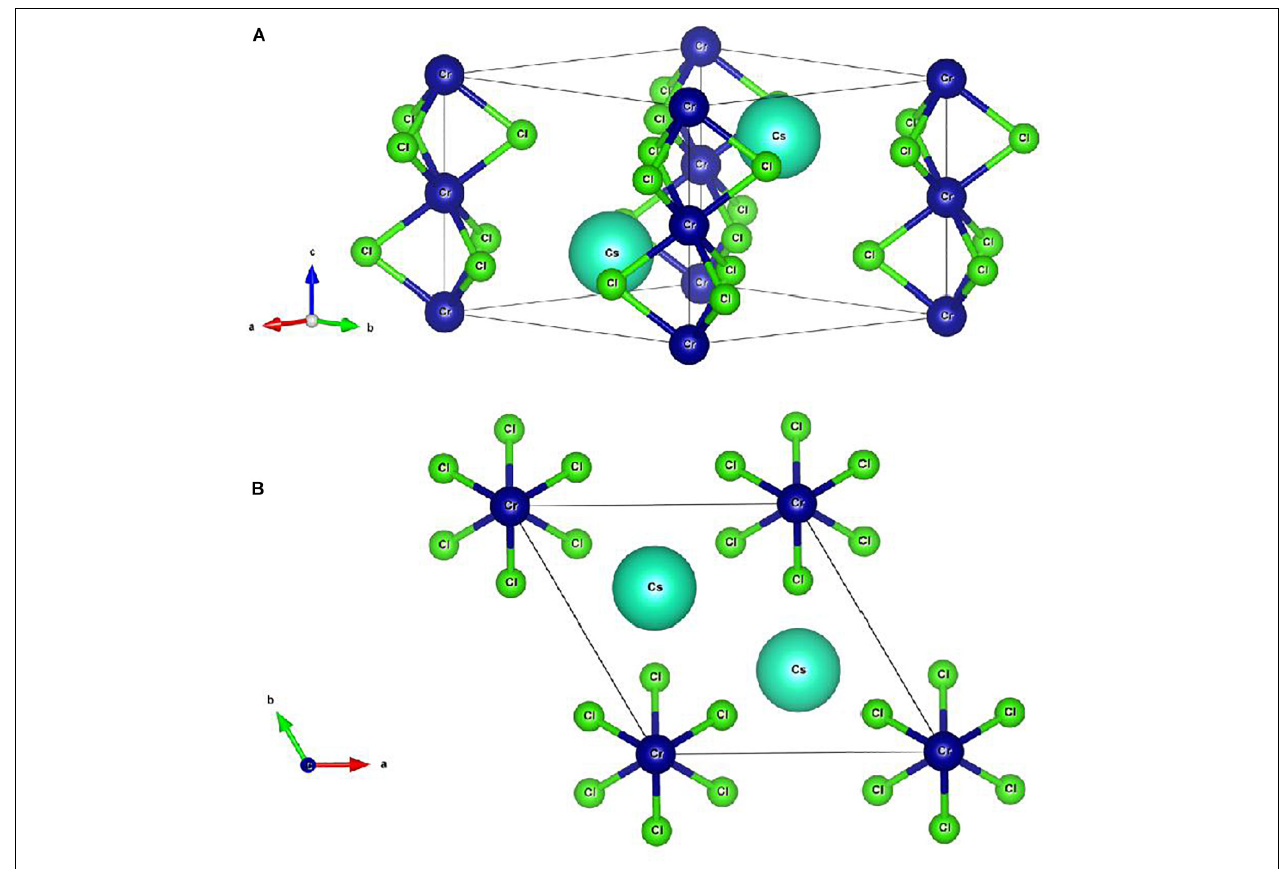
FIGURE 1 | Crystal model of CsCrCl 3 from different perspectives (A,B) .